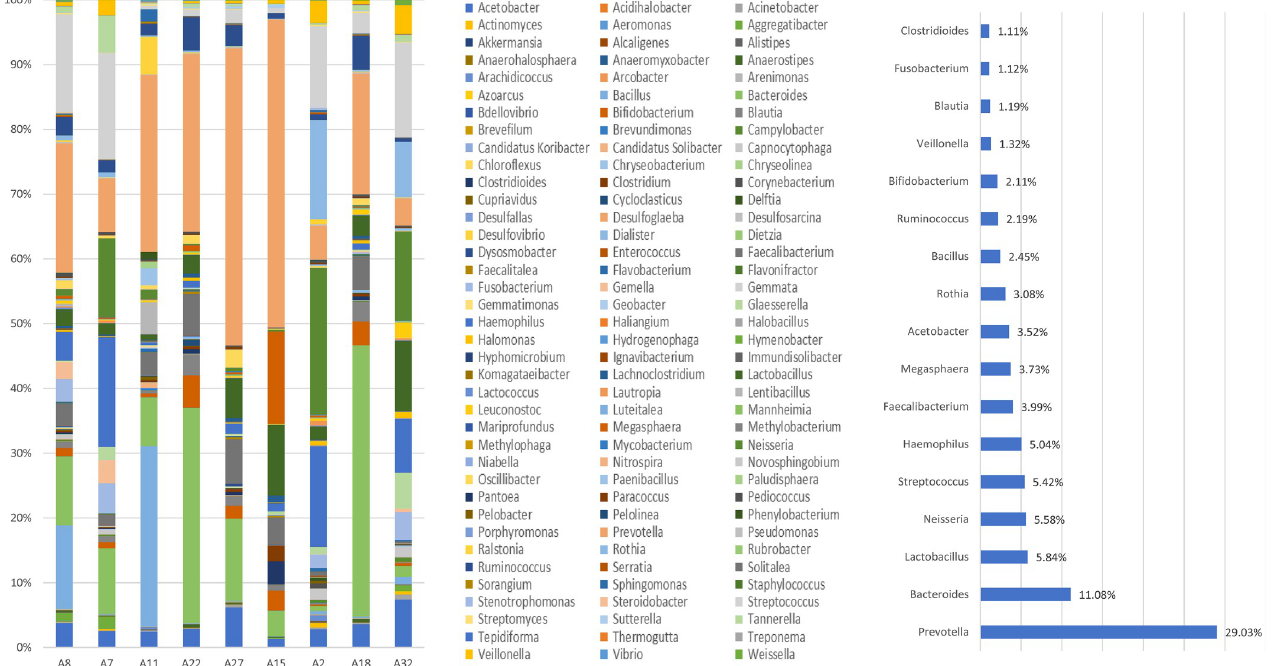
Fig 1. a. Genus-level oral microbiome composition of Betel quid Chewers: 114 genera including Prevotella (29%), Bacteroides (11%), Lactobacillus , Neisseria , Streptococcus , and Haemophilus (5%); b. Abundant genera detected in the Betel quid chewer individuals (excluding genera detected in lower than 1% of relative abundance among the samples).